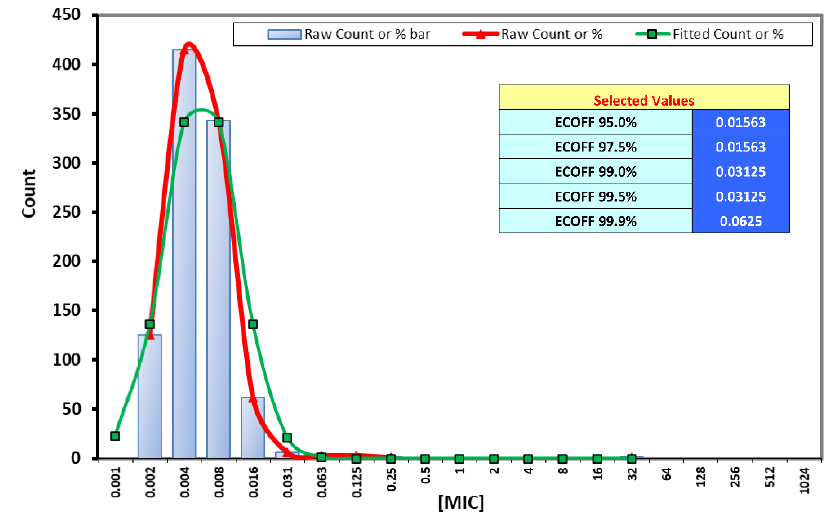
Figure 3. Estimation of wild-type minimum inhibitory concentration (MIC) distributions and ECOFFs for rifampicin against Cutibacterium.